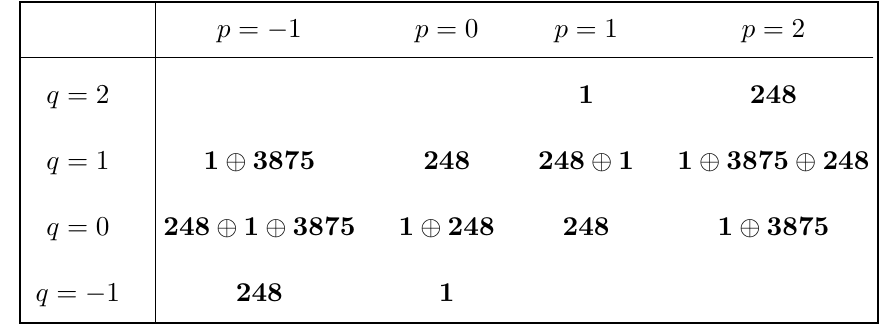
Table 7 . Basis elements of W ( E 9 ). The modules not present in B ( E 9 ) are marked blue. Note the presence of e R 1 = 1 .